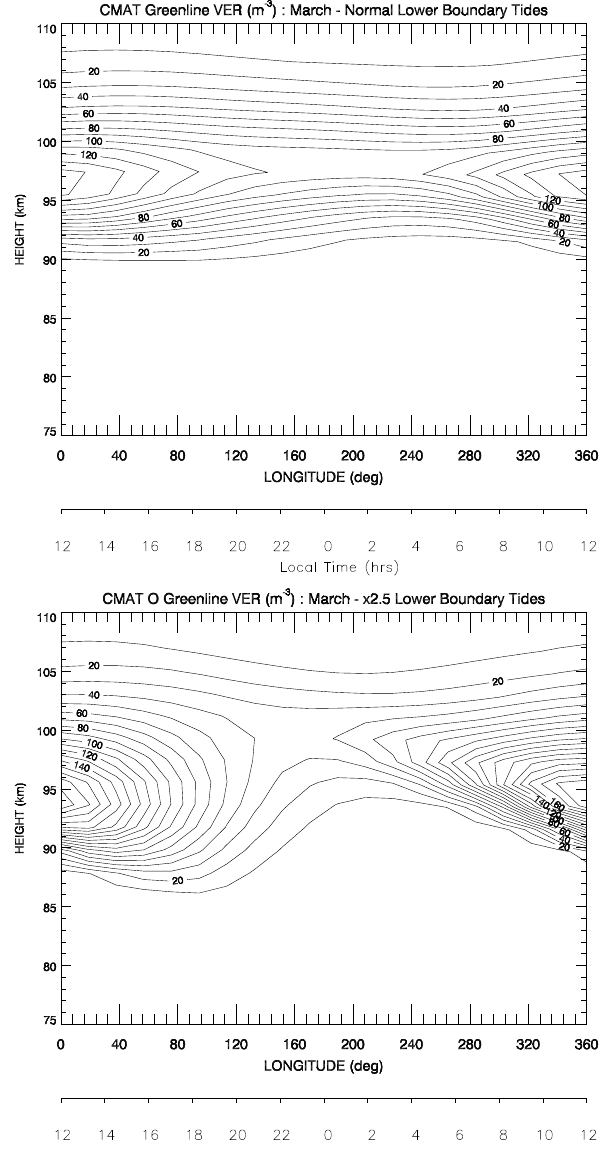
Fig. 9. Local time variation of 557.7nm green line volume emission rate (s − 1 m − 3 ) as calculated by CMAT for March at the equator, with normal lower boundary tidal forcing (top), and × 2 . 5 lower boundary tidal forcing (bottom).